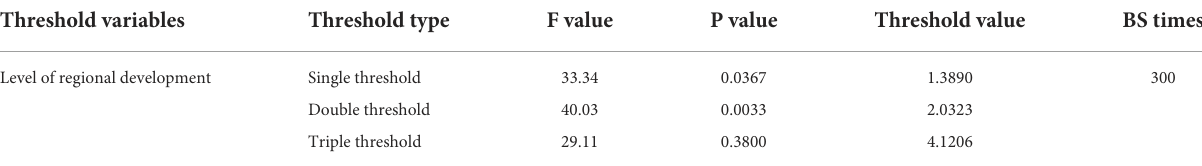
TABLE 6 The existence test of the threshold effect of the regional development level.